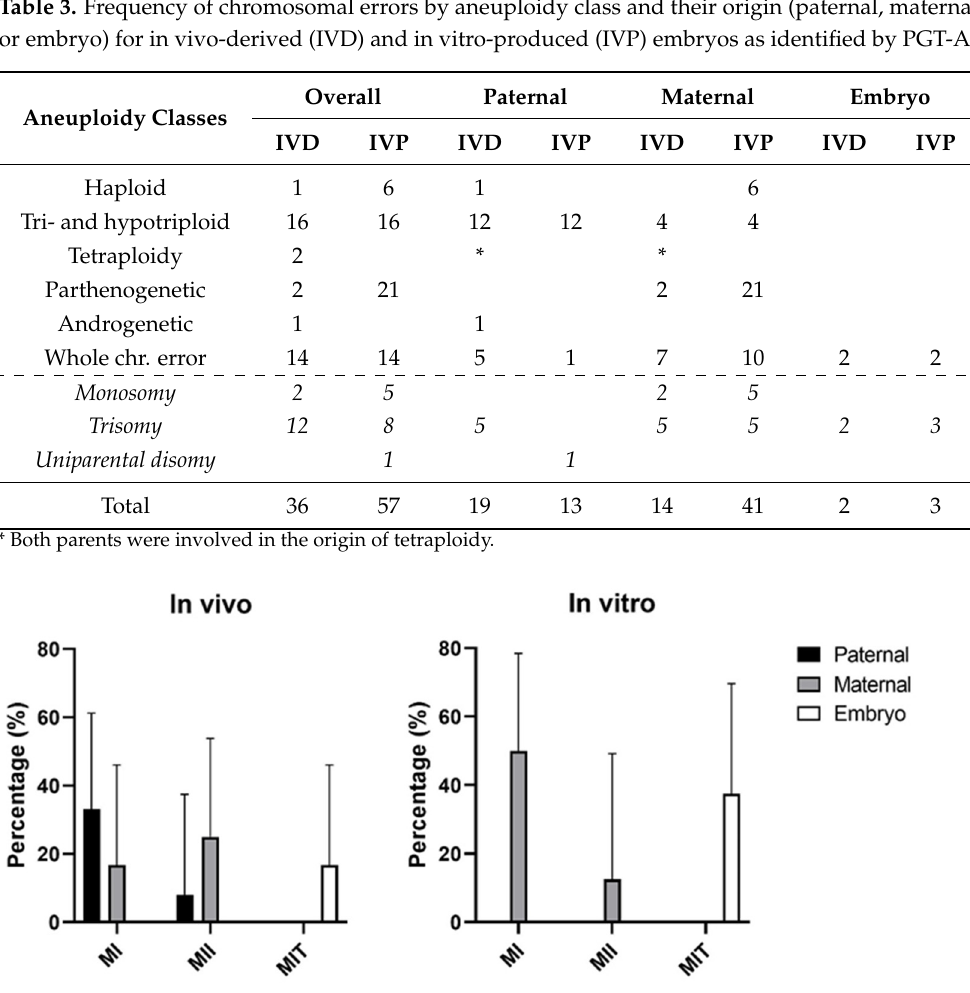
Figure 5. Origin of trisomies (MI; meiosis I, MII; meiosis II, and MIT; mitotic errors during embryonic development) as determined by Gabriel–Griffin plots for IVD and IVP embryos. Data presented as percentage with 95% CI.